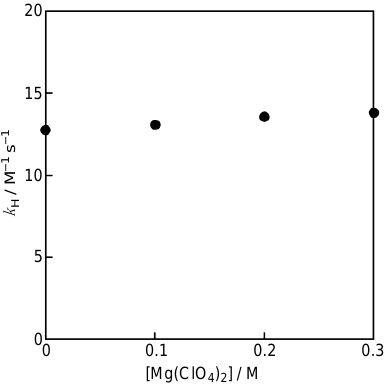
Figure 5. Plots of k H vs. concentrations of Mg(ClO 4 ) 2 .